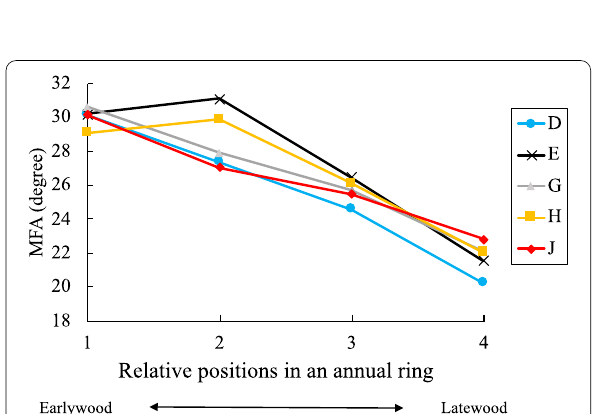
Fig. 9 Effects of initial tree density on the transition from earlywood to latewood in MFA in the ring number 22. Each plot was mean of five sample trees in each tree-density-zoning symbol. Initial tree density zoning symbols were the same, as shown in Table 1